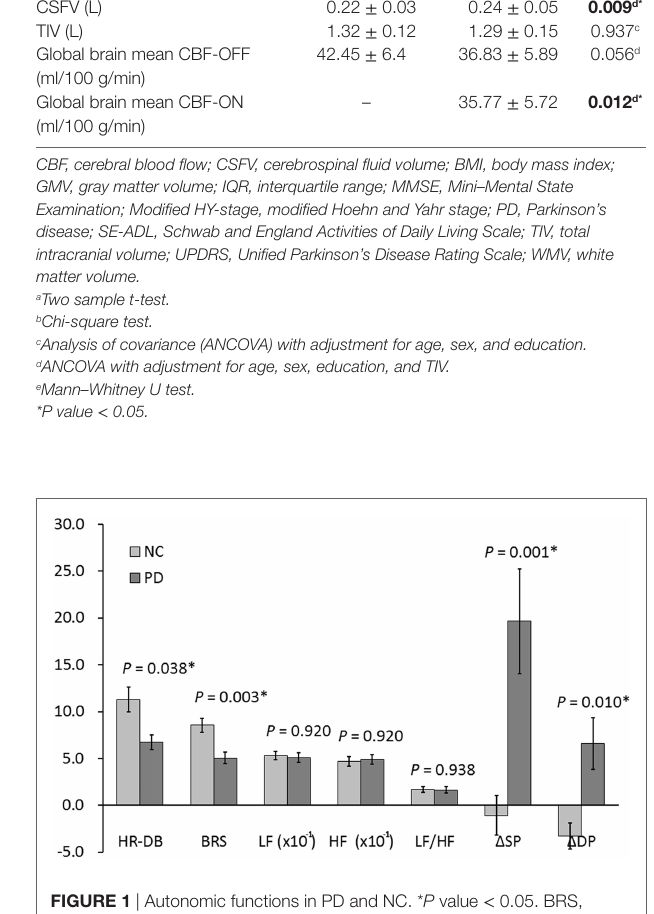
FigUre 1 | Autonomic functions in PD and NC. * P value < 0.05. BRS, baroreflex sensitivity; DP, diastolic pressure; HF, high frequency; HR_DB, heart rate response to deep breathing; LF, low frequency; NC, normal control; PD, Parkinson’s disease; SP, systolic pressure.